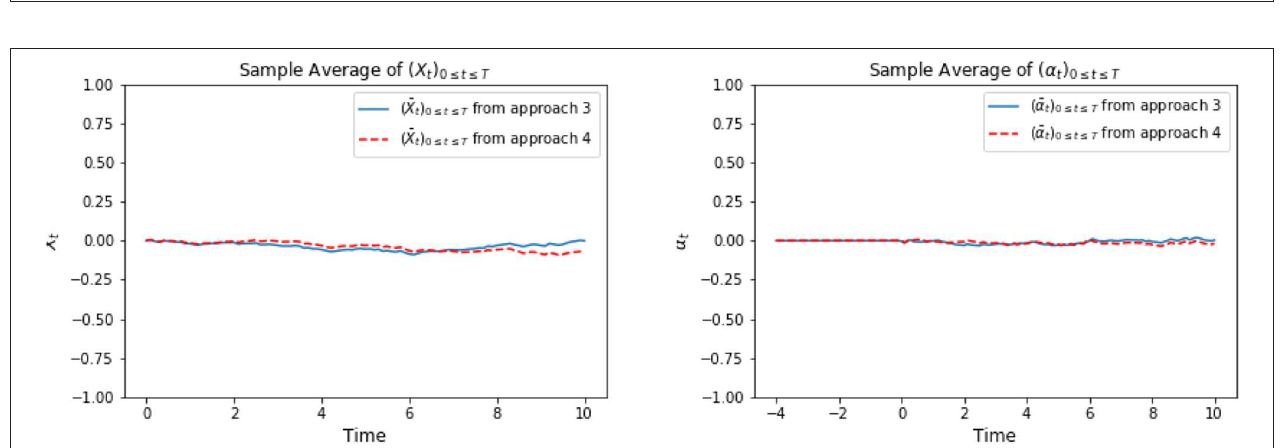
FIGURE 3 | On the left, we compare one representative optimal trajectory of ( X t trajectory of ( α t ) t between approach 3 and approach 4. i 0 ≤ t i ≤ t N